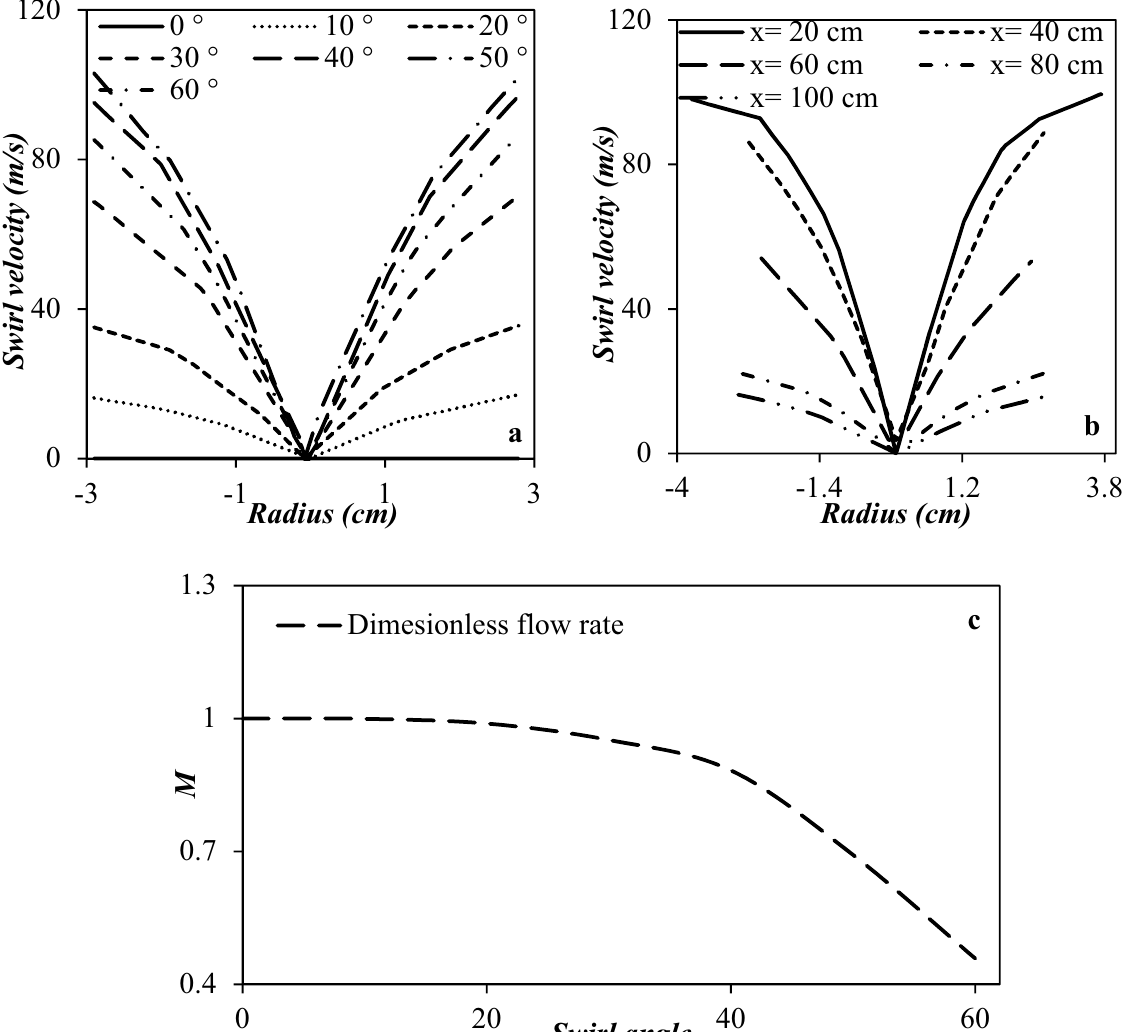
Figure 11. Swirl velocity (at x = 0.35 m) ( a , b ) and dimensionless mass flow ( c ) rate for ( a , c ) various swirl angles ( b ) swirl angle of 40° at various